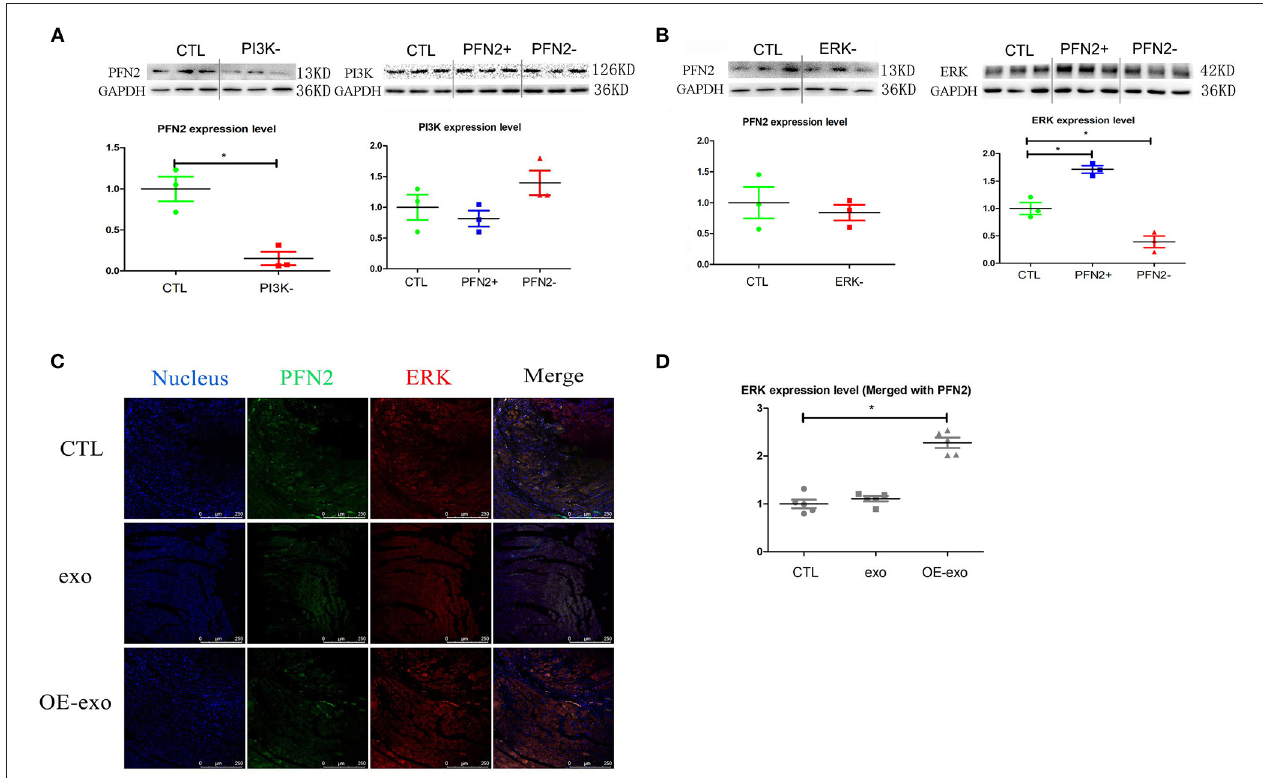
FIGURE 6 | PFN2 involved molecular signaling pathway. (A) PFN2 expression level in HUVECs treated with PI3K inhibitor and PI3K expression level in OE and KD, n = 3, normalized to control. (B) PFN2 expression level in HUVECs treated with ERK inhibitor and ERK expression level in OE and KD, n = 3, normalized to control. (C) ERK and PFN2 expression levels in the heart tissue of MI mice treated with different exosomes, n = 3, normalized to control. (D) Statistical result of (C) . * p < 0.05, Student’s t -test and one-way ANOVA (Tukey).